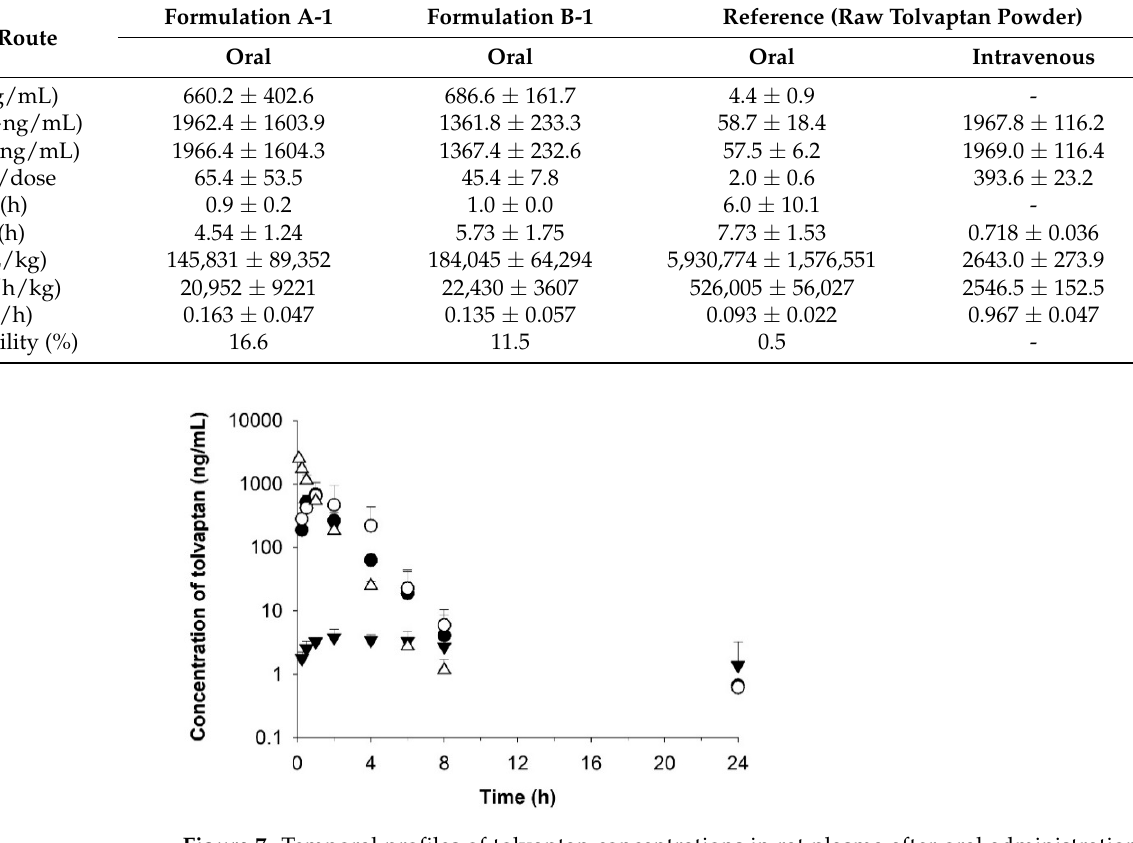
Table 6. Pharmacokinetic parameters of optimized tolvaptan-loaded SMEDDS (formulations A-1 and B-1) and raw tolvaptan powder in rats after intravenous administration of 5 mg/kg and oral administration of 30 mg/kg. Data are shown as the mean ± SD ( n = 4).